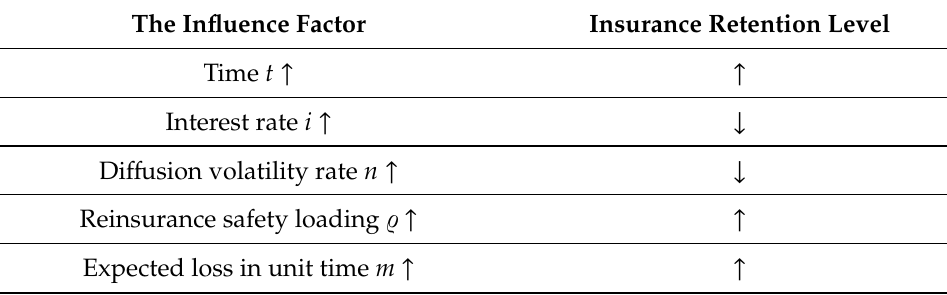
Table 1. Factors that a ff ect reinsurance